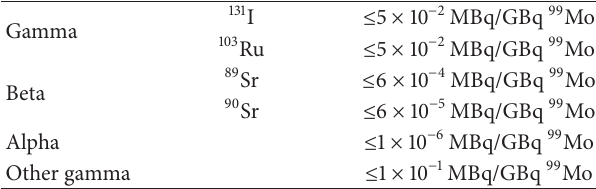
Table 4: Radioactivity distribution between precipitate and filtrate after dissolving irradiated nat. U-targets of original composition.